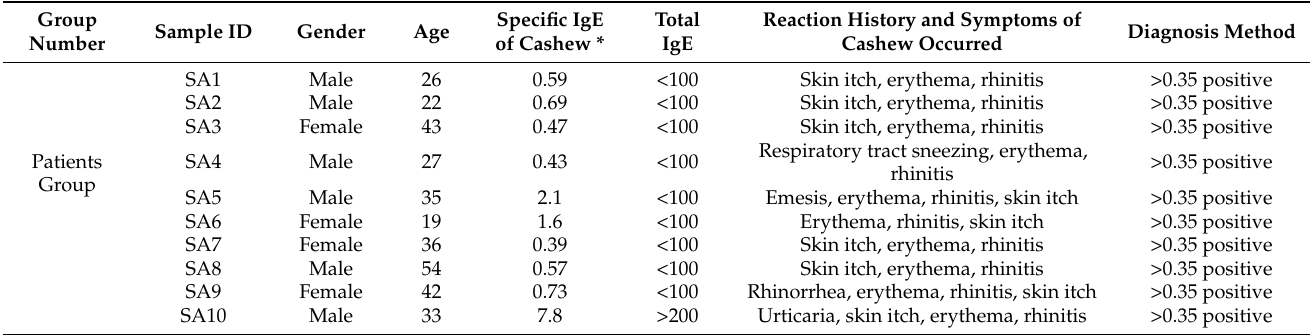
Table 3. The patients’ hospital records of cashew